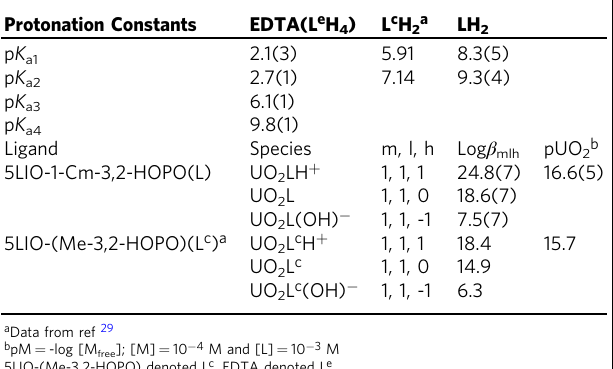
Table 1 Protonation Constants of Ligands and Uranyl Chelation Stability Constants Protonation